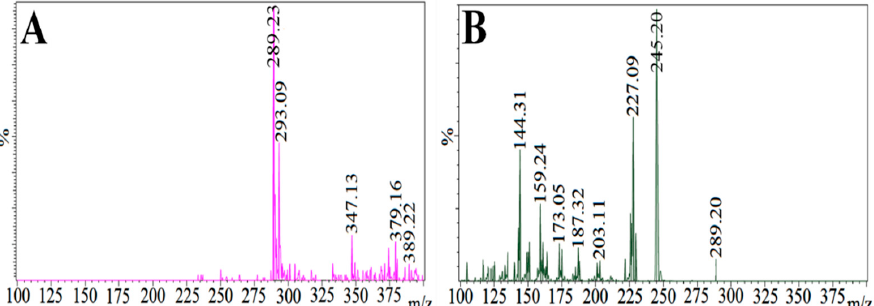
Figure 9. Mass spectrum of ( A ) catechin hydrate (CH) parent ion (protonated precursor [M–H] − ions at m / z 289.23) and ( B ) catechin hydrate (CH) product ion (major fragmented product ion at m / z 245.20) showing fragmentation transitions.